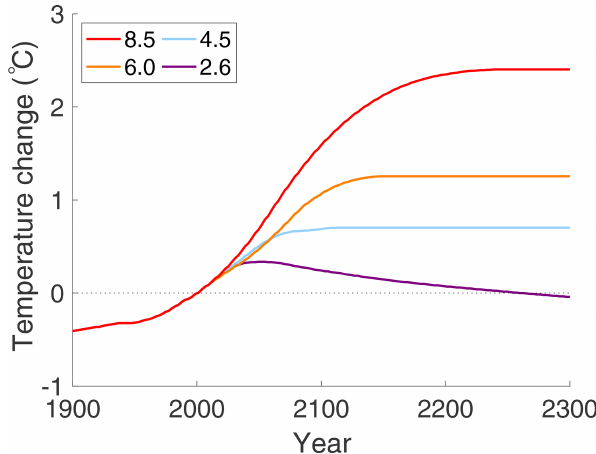
Figure 11. Tropical surface temperature changes for the four RCP scenarios, forecast to year 2300 relative to year 2000 (25 . 19 ◦ C), with constant F O and F A . The temperature change is relatively small in the